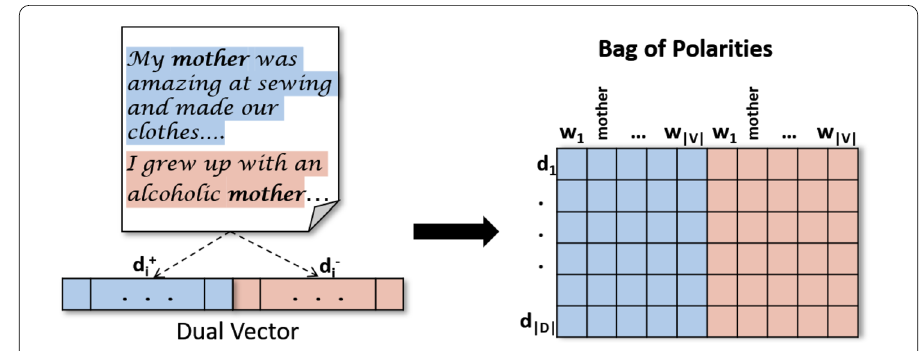
Figure 2 The bag of polarities representation; in it each document from the collection is represented by a dual vector that captures the occurrence of words in both positive and negative contexts